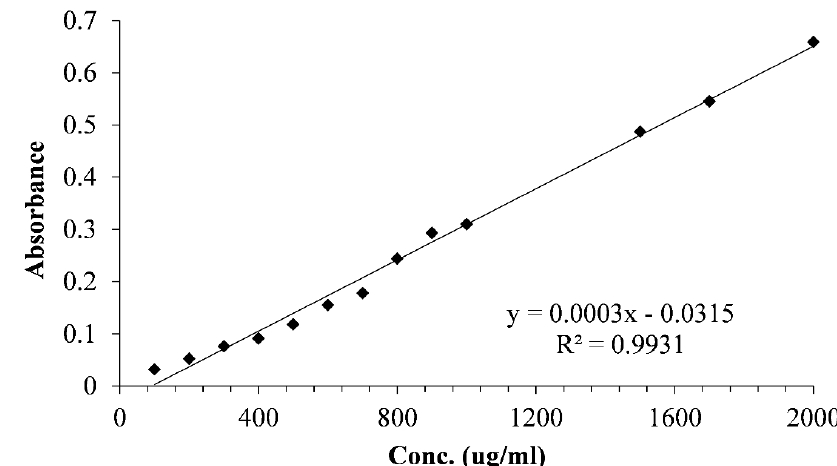
FIGURE 2 - Calibration curve without derivatization at pH 1.2 at